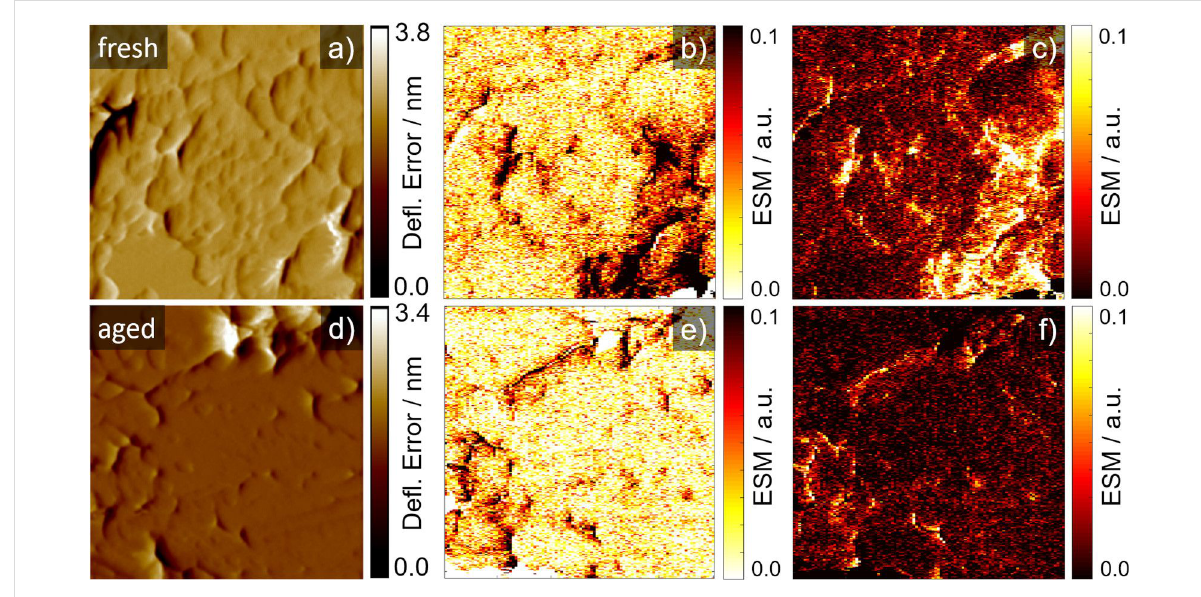
Figure 5: ESM measurements of a fresh (top row) and aged cathode (bottom row) cross-section. a) and d) show the deflection error, b) and e) ESM signal during positive voltage pulse and c) and f) during negative voltage pulse. Scan size is 1 × 1 µm 2 .